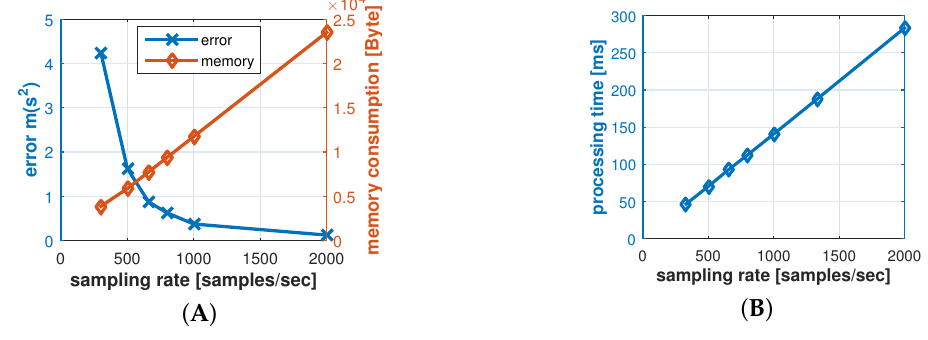
Figure 10. Sampling rate trade-offs: ( A ) memory to error rate; and ( B ) processing